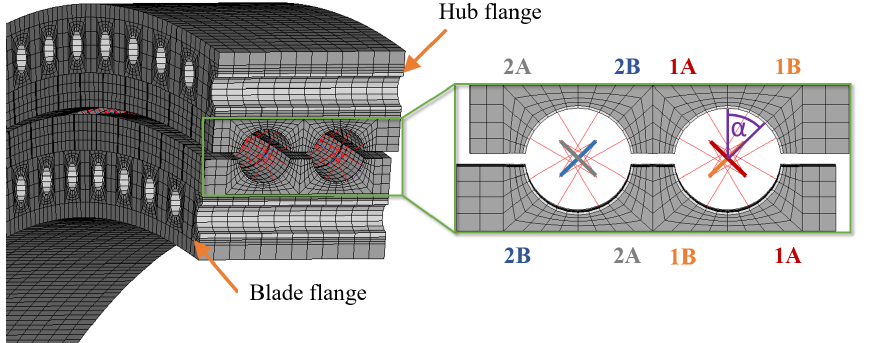
Figure 3. Bearing cross section and raceway definitions.